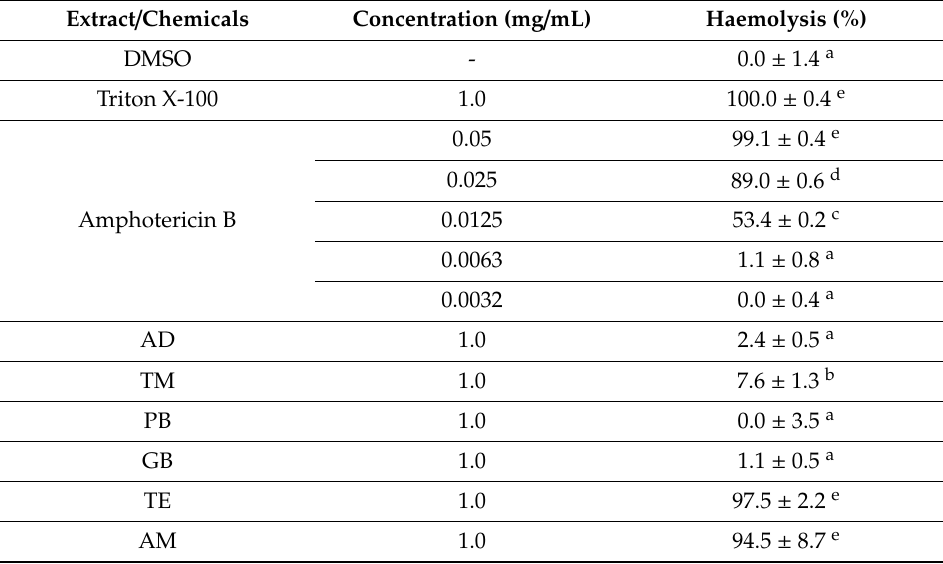
Table 5. Haemolytic activities of the ethanol extracts of 6 di ff erent insect extracts. Extract /